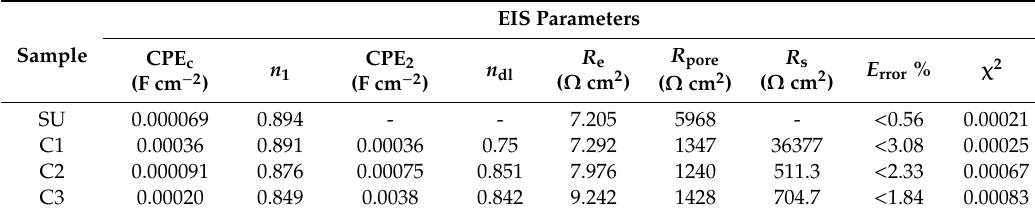
Table 3. EIS data obtained by equivalent circuit obtained simulation of coated and uncoated specimens exposed in 2 wt.% H 2 SO 4